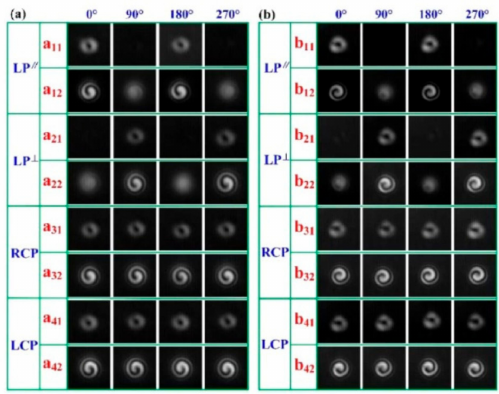
Figure 31. Beam profiles and interference patterns of the generated ( a ) OAM + 1 modes and ( b ) OAM − 1 modes by using right-handed and left-handed HLPFG in TMF, respectively